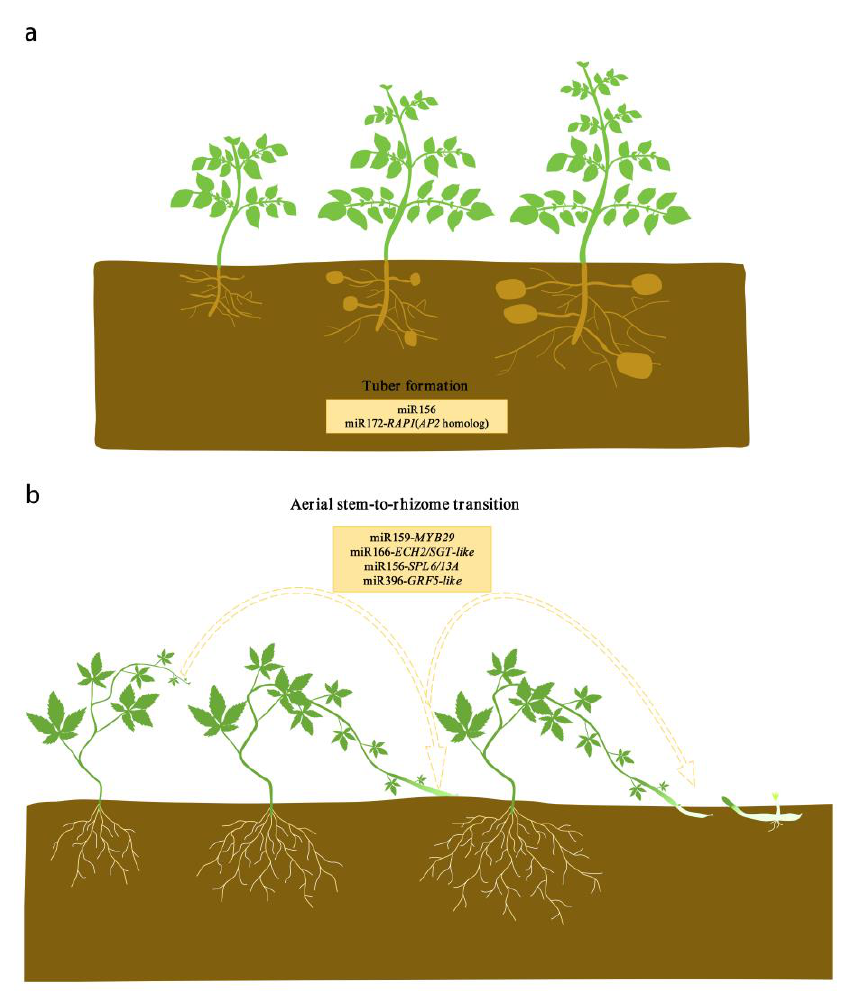
Figure 2. MiRNAs and their targets regulate the formation of storage organs. ( a ) MiR156 and miR172- RAP1 ( AP2 homolog) module regulate the stolon-to-tuber transition in potato. ( b ) MiR159- MYB29 , miR166- ECH2 / SGT -like, miR156- SPL6 / 13A , and miR396- GRF5 -like modules are involved in the aerial stem-to-rhizome transition of Gynostemma pentaphyllum . In G. pentaphyllum , the subapical regions of some aerial stems swell and then drill into the soil to form rhizomes that produce new plants in the next year, which is an adaptive regenerative strategy that enables it to survive during winter.